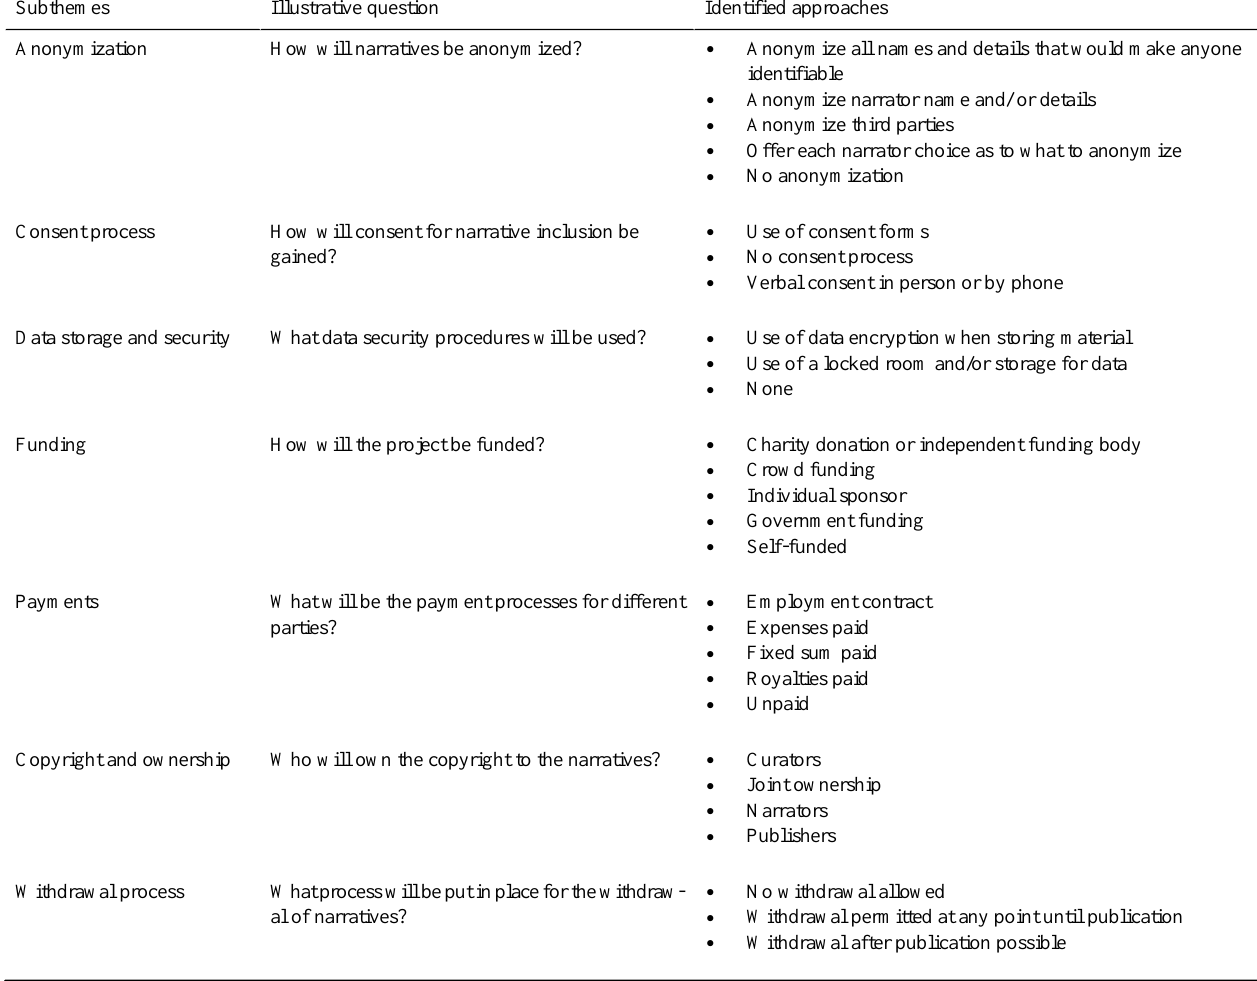
Table 6. Ethical and legal considerations in the curation of